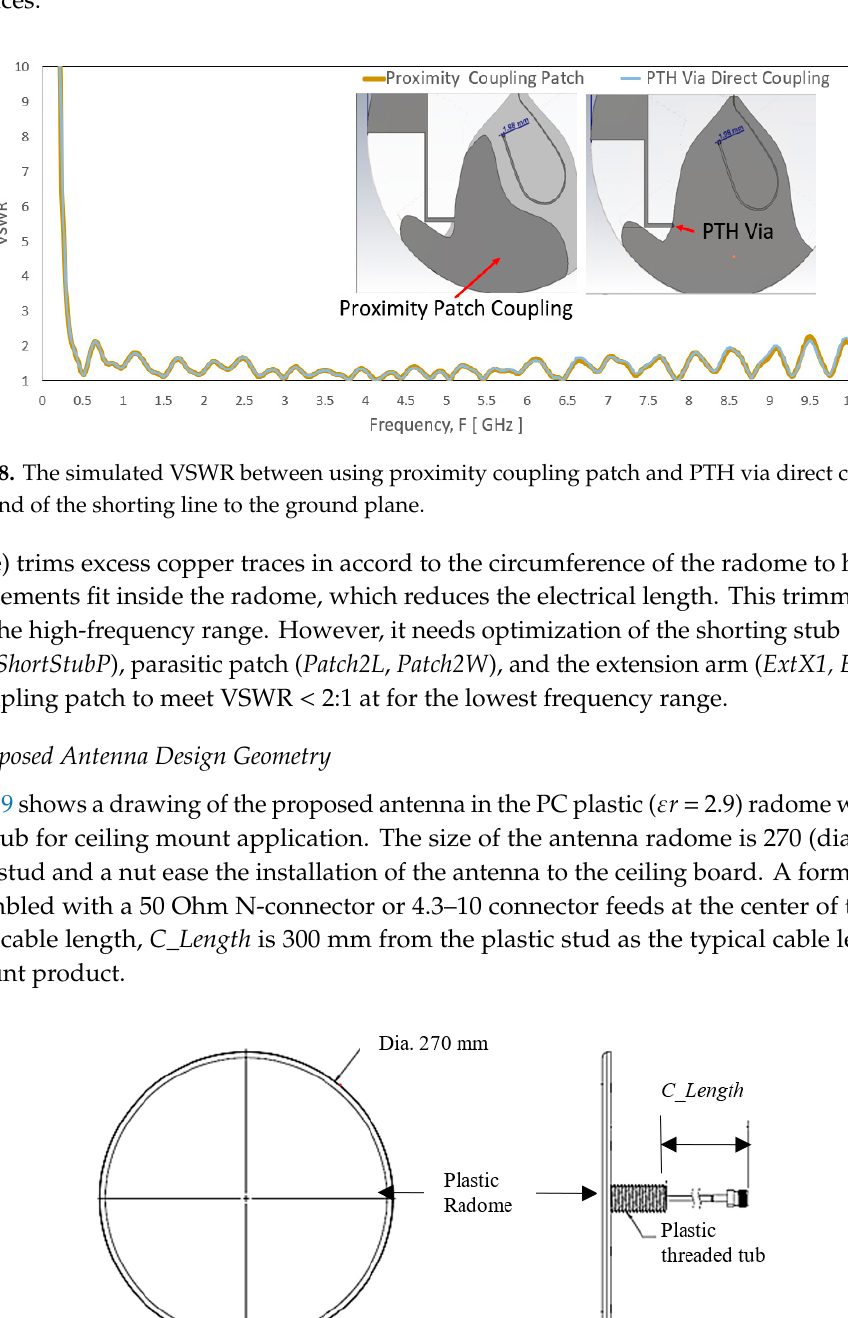
10 of 33 Figure 7. The simulated VSWR of the evolution steps from Figure 4: Step (c) to Step (e). Although step (c) increases the bandwidth for the range of 350 to 520 MHz, the VSWR for a few frequencies higher than 2:1 for frequency below 2700 MHz. The ground coupling patch area to the ground plane is inadequate to have functional coupling to the ground plane that leads to the VSWR spike at 726 MHz. In step (d), a larger surface of the coupling patch slightly improves the VSWR spike at 726 MHz. The ground coupling patch outline partially follows the shape of the ground plane,